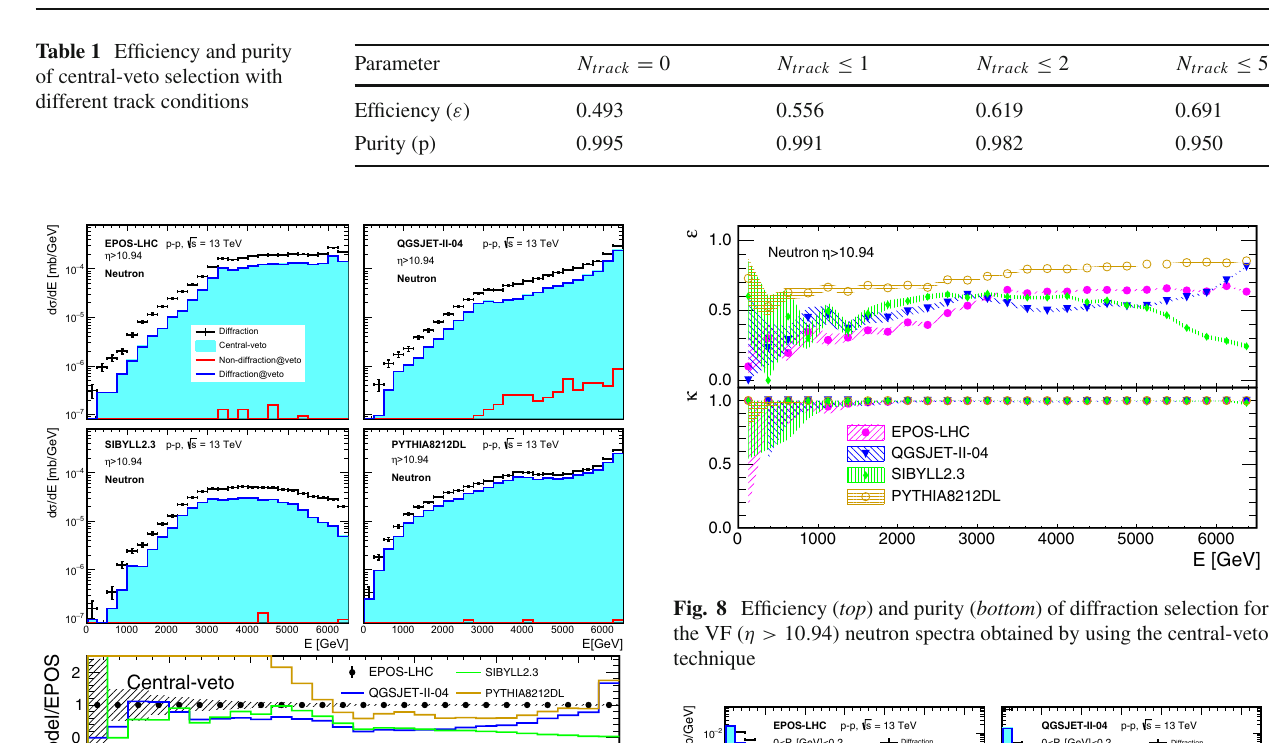
√ s = 13 TeV, respectively.